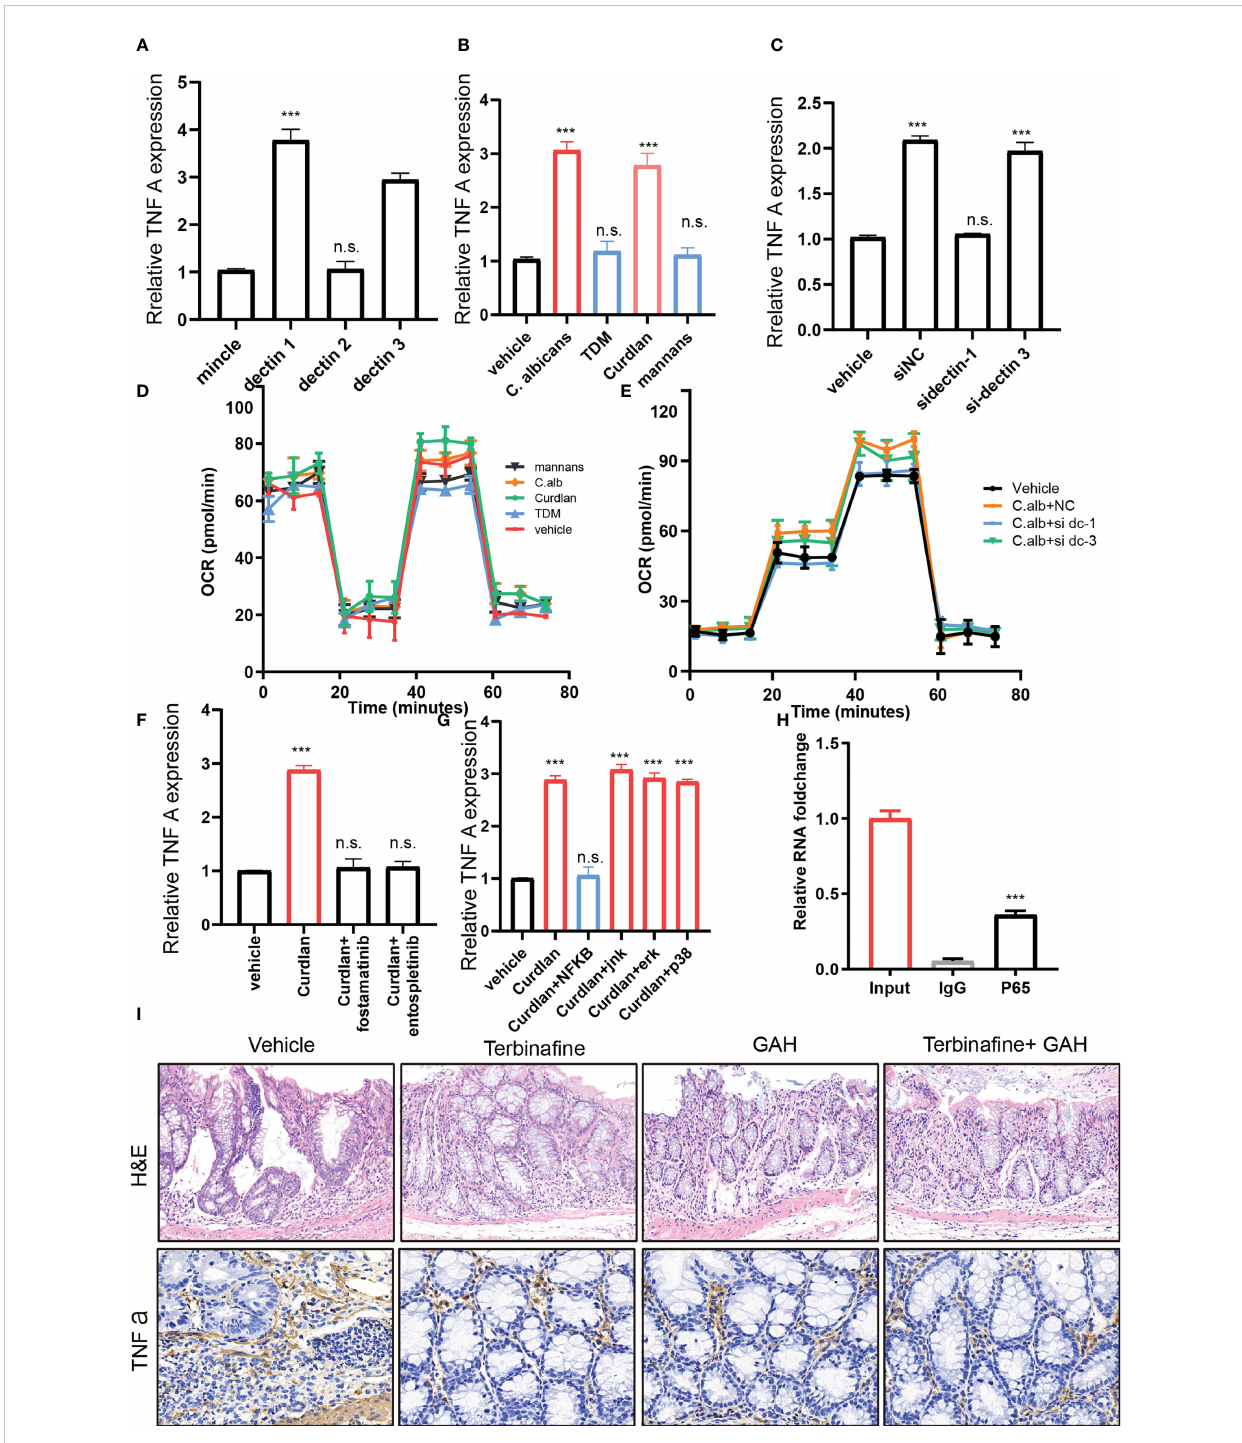
FIGURE 5 Fungi activates dectin-1-Syk- NF- k B aixs to enhancing glutaminolysis in CD4+ T cells. (A) . The relative mRNA expression of fungi recognize receptor expression in the IBD CD 4+ T cells. (B) . The TNF a expression under fungi infection or plus with mincle inhibitor TDM, dectin1 receptor Curdlan or dectin2/3 receptor mannans. (C) . The TNFa expression after dectin receptor knockdown under fungi infection. (D, E) . The OCR level of CD4 + T cells under C-type lectin receptors agonists (D) or C-type lectin receptors agonists knockdown. (F) . The TNFa expression under Curdian or Curdian puls SyK inhibitors. (G) The TNFA expression under Curdian or Curdian puls signaling pathway inhibitors. (H) The CHIP-PCR of TNFA with IgG or P65 antibody. (I) The H&E and IHC staining of colon sections derived from vehicle, terbina fi ne, GAH and terbina fi ne plus GAH treated mice. ***P < 0.001 and n.s., no signi fi cance P >